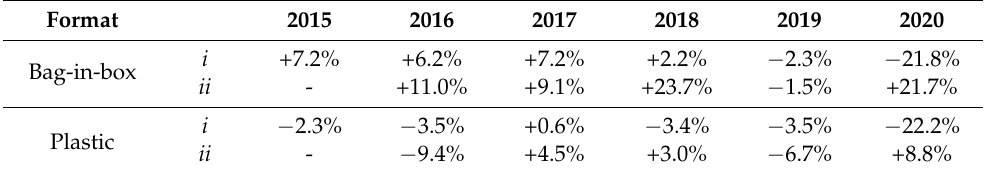
Figure 6. Wine sales in value (million EUR) of bag-in-box and plastic in the 0–3 EUR/liter price range. Table 8. Percentage change of wine sales in value by format in the 0–3 EUR/liter price range compared to the previous period: for each year, ( i ) the variation of b2 compared to b1, and ( ii ) the variation of b2 compared to b2 of the previous year.